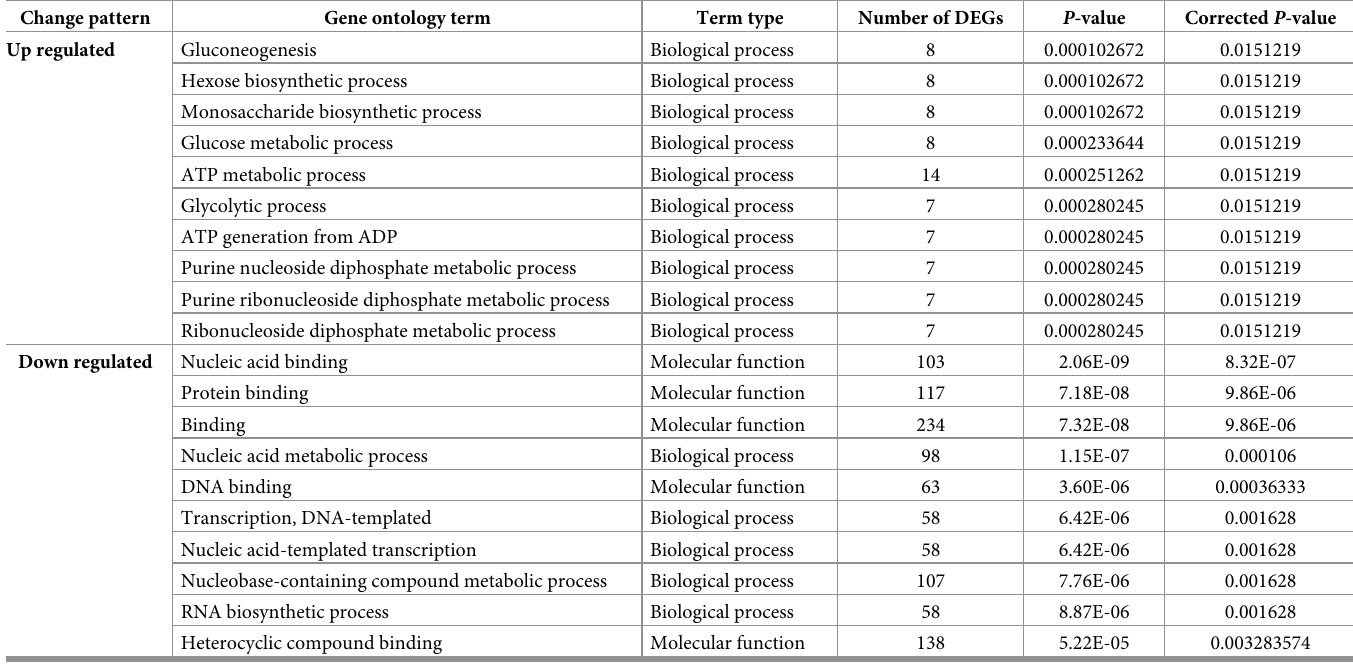
Table 1. Changes identified by GO analysis during T1 to